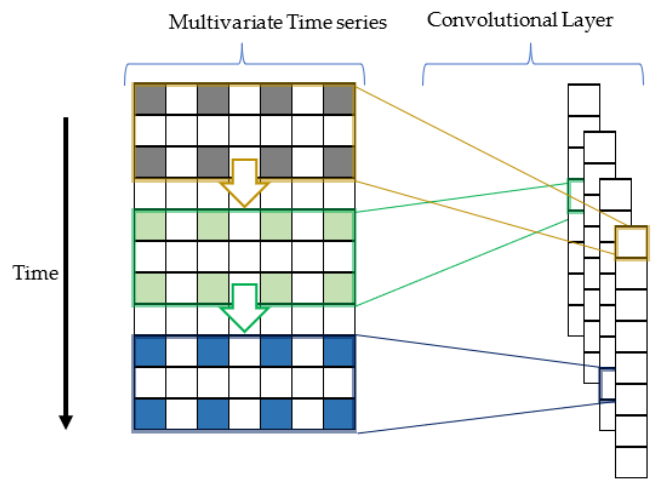
Figure 2. 1D CNN process.